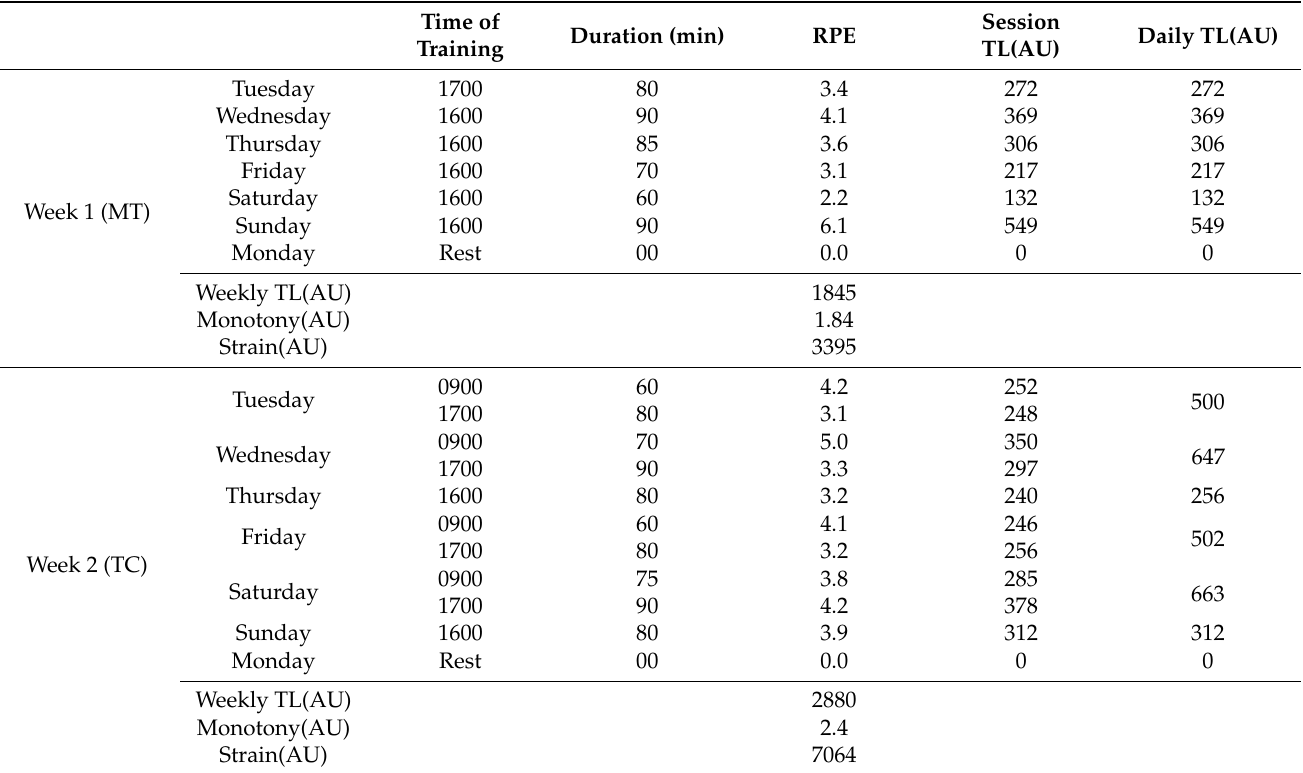
Table 3. The training durations and average rating of perceived exertion (RPE), training loads (TL), monotony, and strain during the moderate training load week (MT) and intensified training camp (TC) ( n = 15).